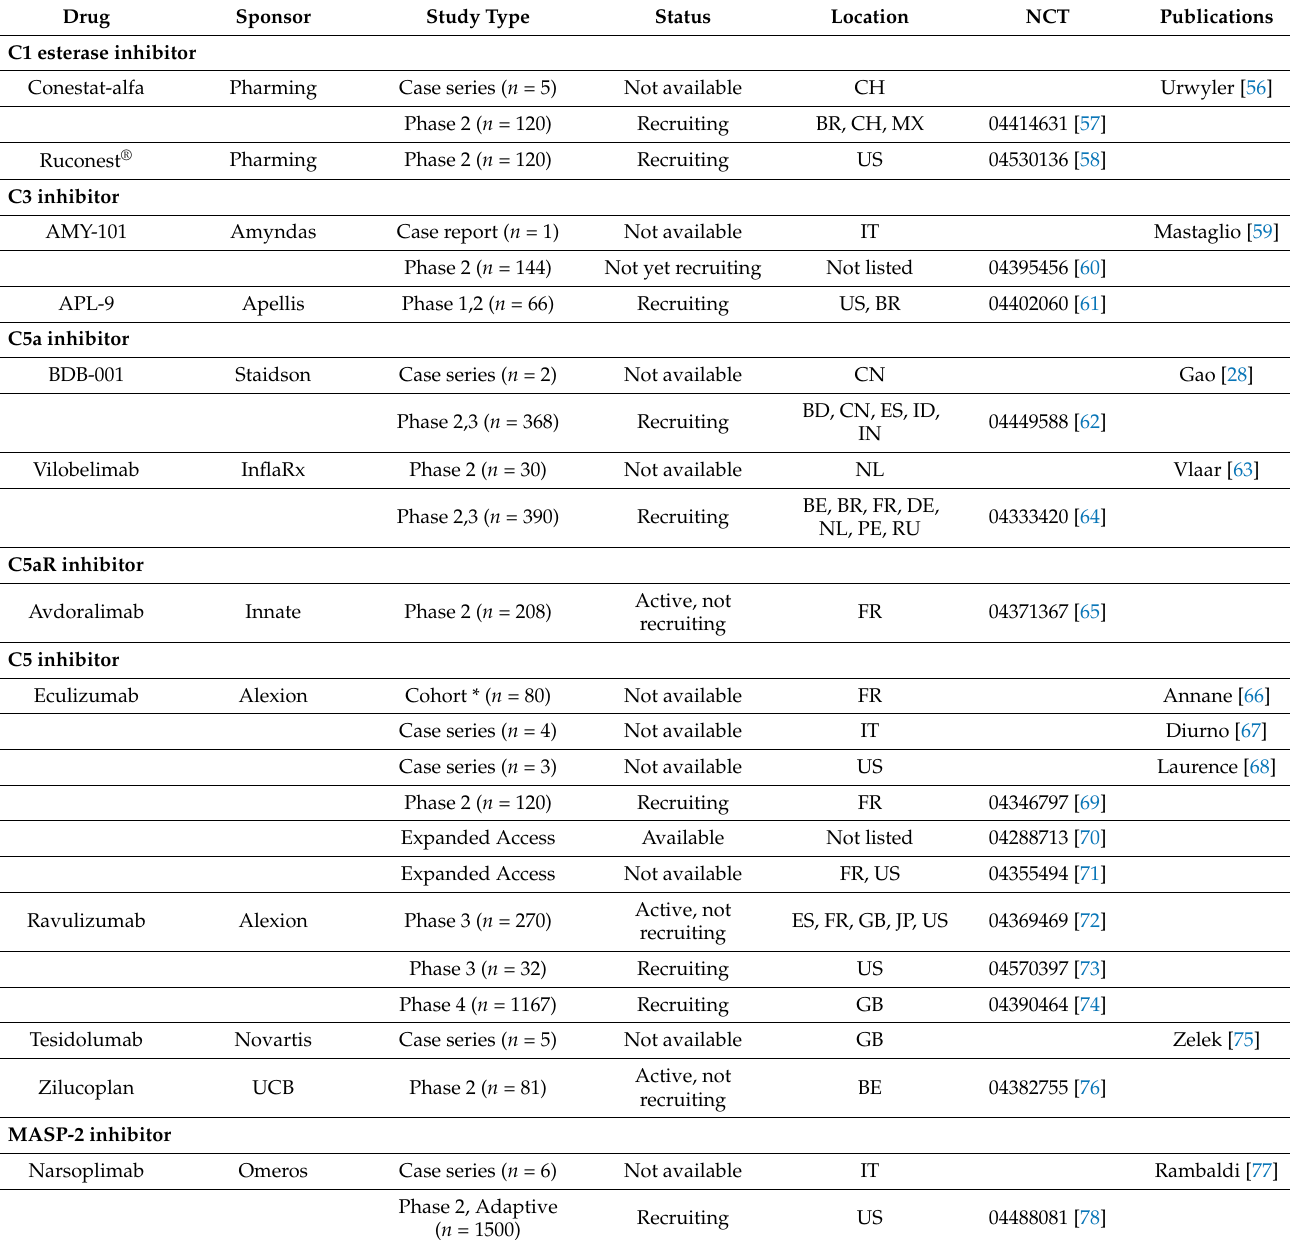
Table 1. Therapeutic targets in the complement cascade for the treatment of COVID-19 pneumonia. * Nonrandomized, controlled cohort study. Abbreviations: NCT: National Clinical Trial. Country Abbreviations: BD: Bangladesh; BE: